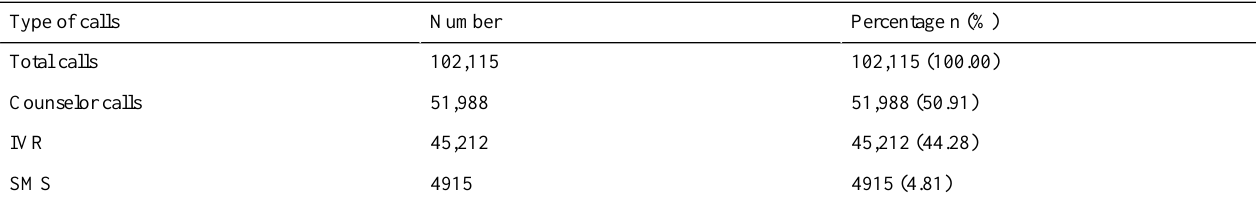
Table 1. Sahaay helpline call volume by service request